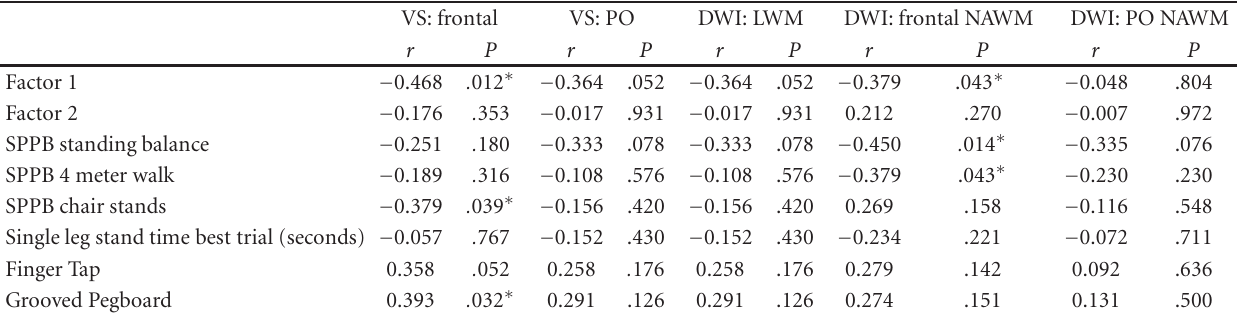
Table 2: Correlations between imaging data and motor performance tests.